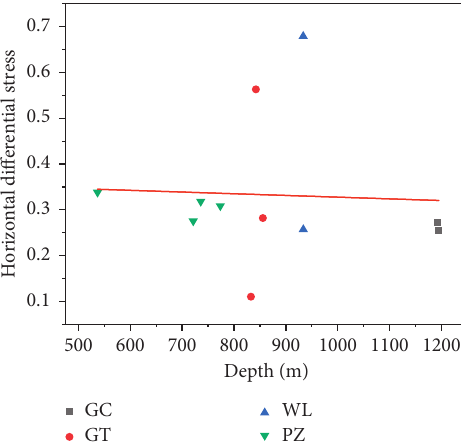
Figure 4: Relationship between the relative magnitude of horizontal difference stress and the buried